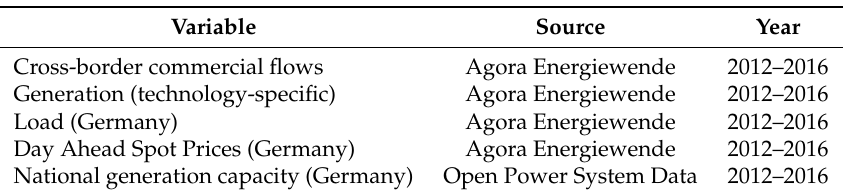
Table 1. Data sources for generation and price data